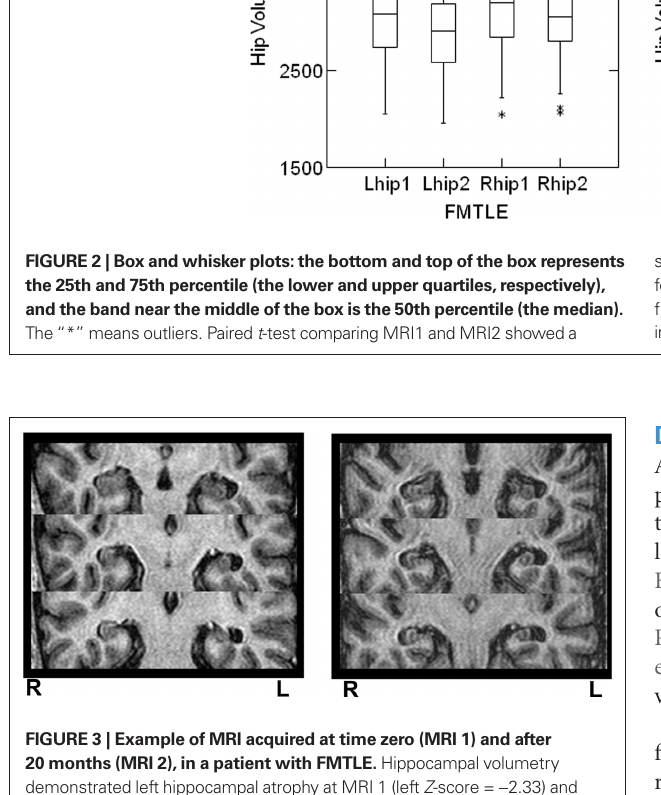
FIguRe 3 | example of MRI acquired at time zero (MRI 1) and after 20 months (MRI 2), in a patient with FMTLe. Hippocampal volumetry demonstrated left hippocampal atrophy at MRI 1 (left Z -score = − 2.33) and bilateral hippocampal atrophy at MRI 2 (left Z -score = − 3.63 and right Z -score = − 2.81), indicating progression of left hippocampal atrophy and the development of right hippocampal atrophy overtime. R, right side; L, left